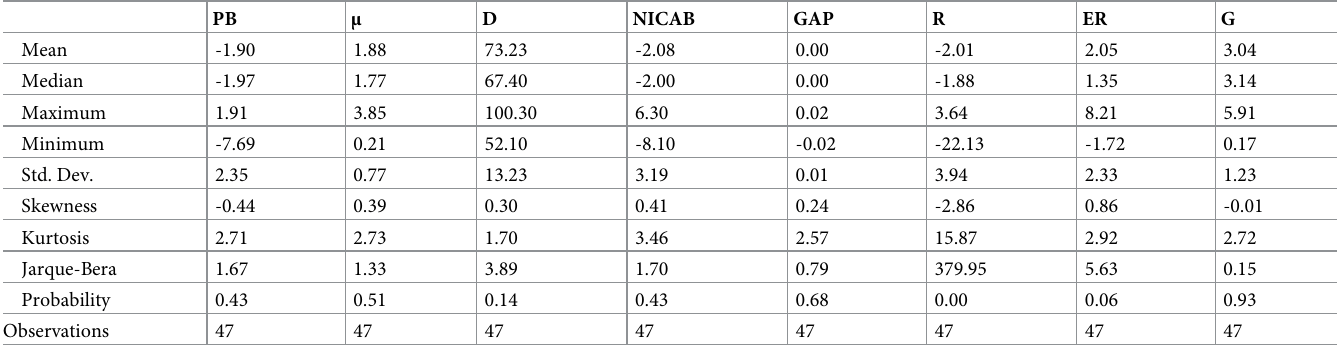
Table 3. Descriptive